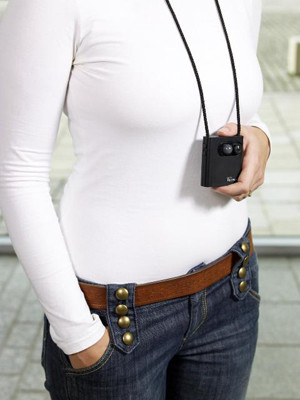
The Microsoft SenseCam digital camera.
This wearable device weighs 175 g and passively captures approximately 3,600 first-person point-of-view digital images per typical day.